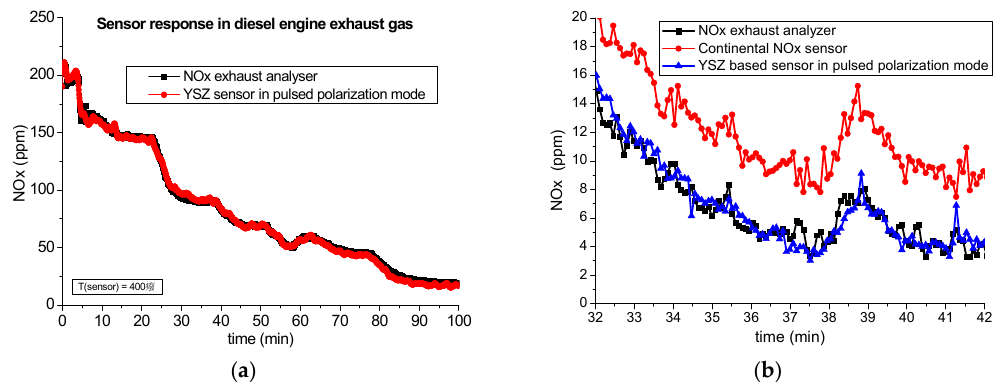
Figure 3. ( a ) Comparison of the response of a commercial NOx exhaust analyzer and a calibrated YSZ sensor in pulsed polarization mode in diesel engine exhaust gas; ( b ) Comparison of the response of an NOx exhaust analyzer, a commercial amperometric NOx sensor and a calibrated YSZ sensor in pulsed polarization mode in diesel engine exhaust gas at low NOx